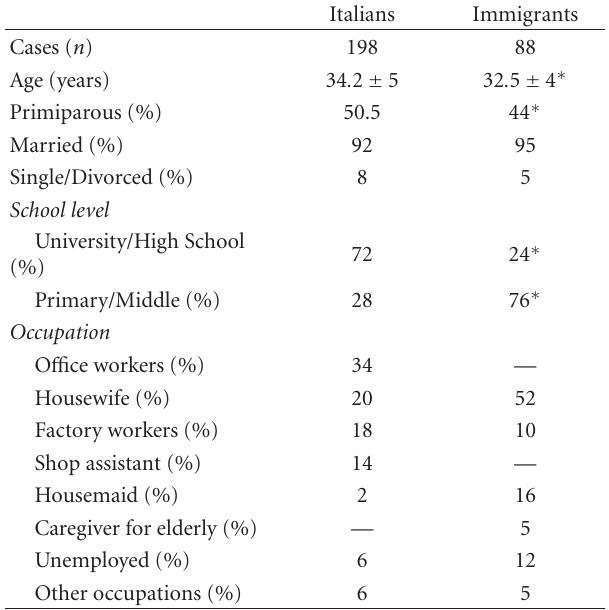
Table 1: General characteristics of women with